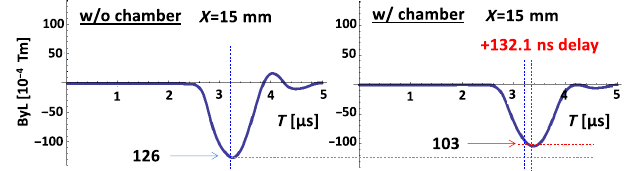
FIG. 4. Strength reduction and timing delay as a result of the effects of eddy currents in a pulsed field. The pulse width of the half-sine waveform with the chamber widened from 1.2 to 1 . 5 μ s compared with the case without the chamber.